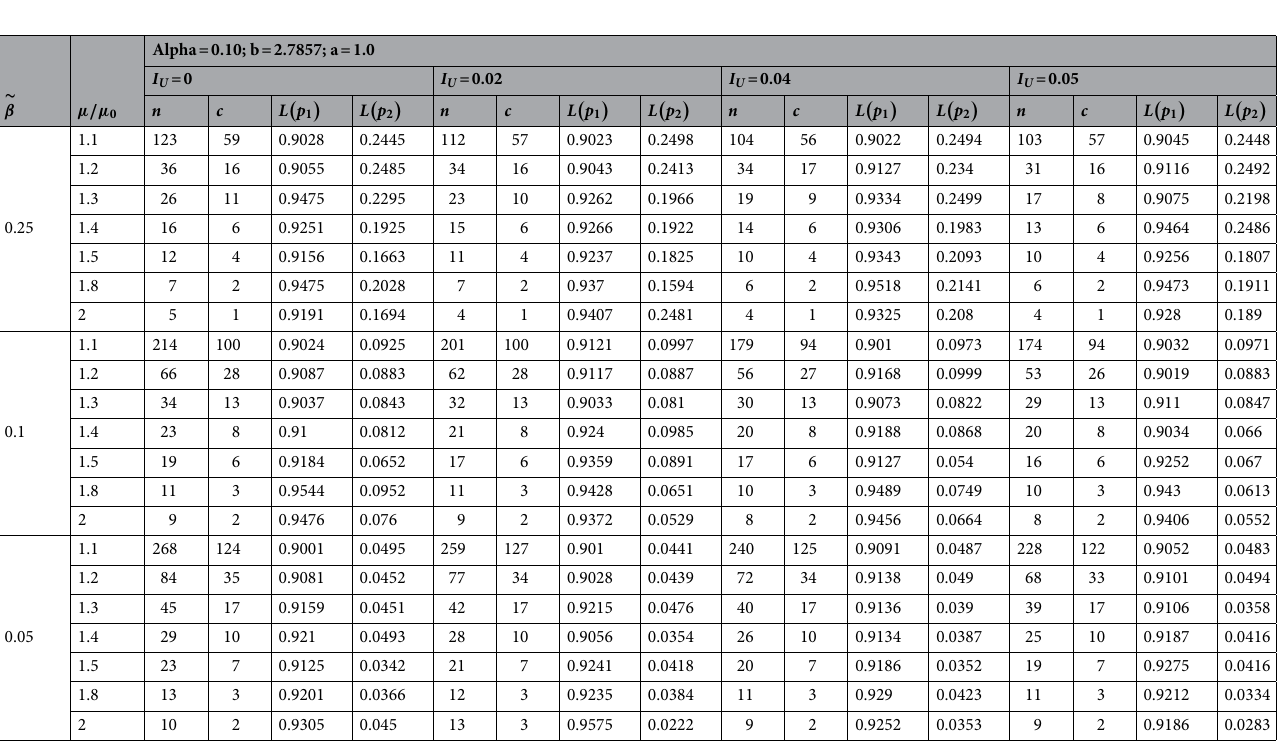
∼ α = 0.10 ; β = 2.7857 and a = 0.10